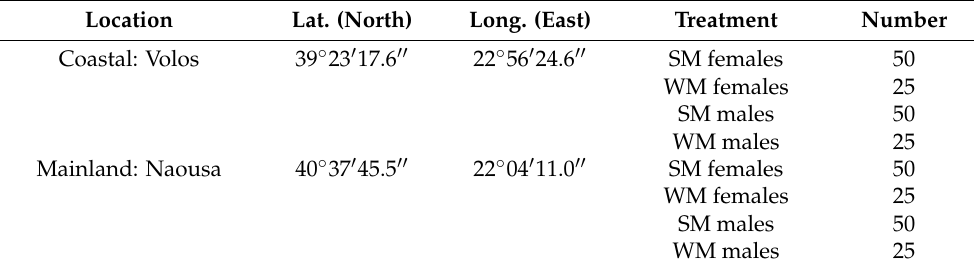
Table 1. Coordinates of two geographic locations: a coastal area with mild winter in central Greece (Volos) and a mainland area with cold winter in northern Greece (Naousa), where D. suzukii adults (SM and WM of males and females) were transferred from autumn 2019 until spring 2020. Location Lat.